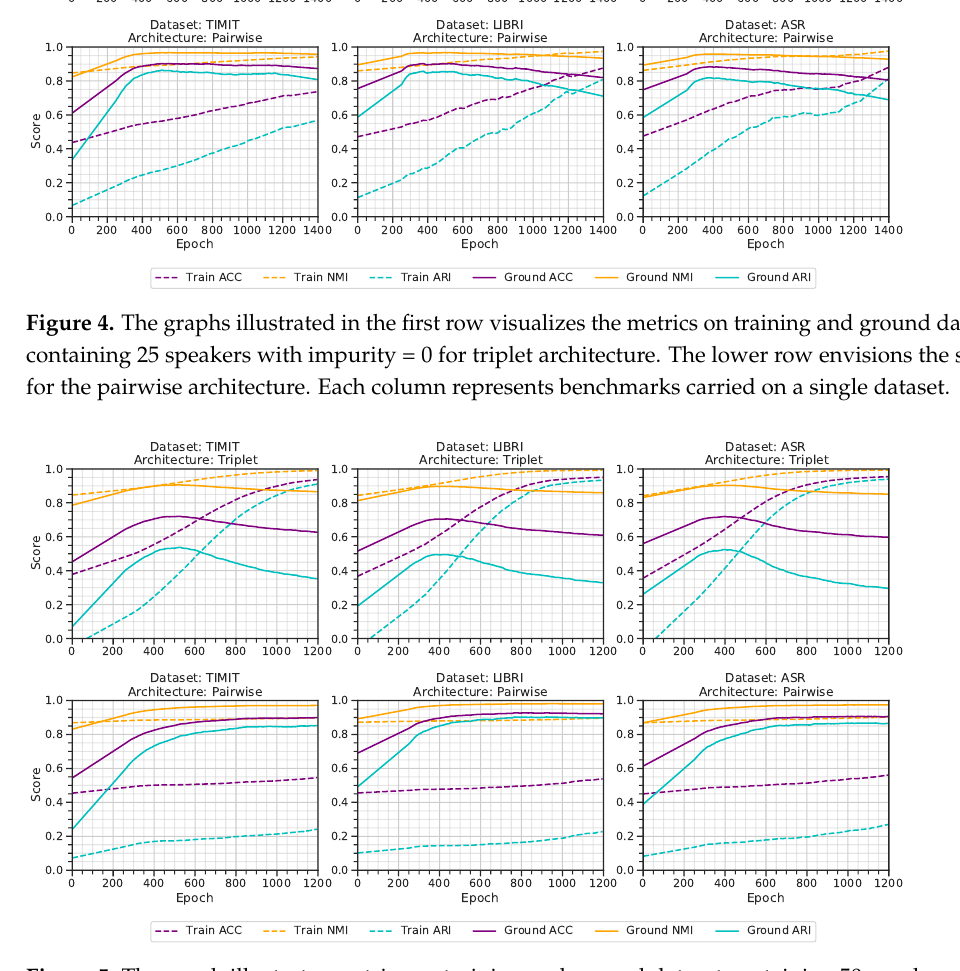
Figure 5. The graph illustrates metrics on training and ground dataset containing 50 speakers with impurity =